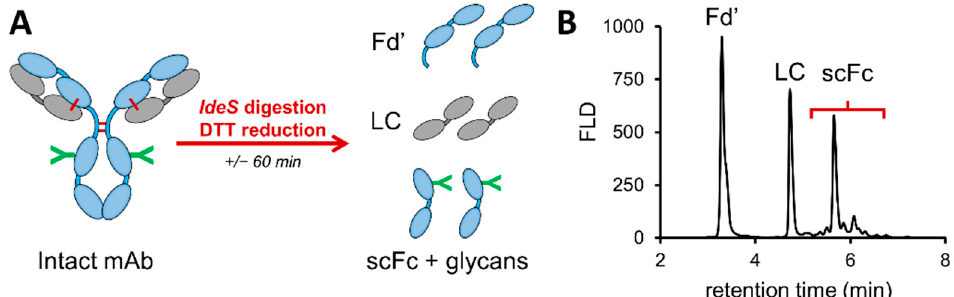
Figure 2. Middle ‐ up HILIC ‐ MS analysis of IdeS digested and DTT reduced adalimumab. ( A ) Sample preparation procedure for the digestion and reduction in intact mAb to protein subunits. ( B ) FLD chromatogram displays the separation of the Fd’, LC and scFc subunits. See Table S1 for detailed retention times and mass assignment.